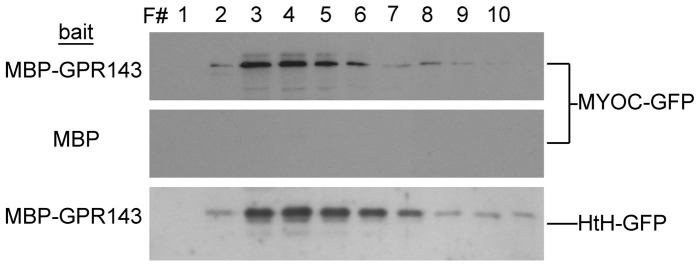
Interaction between myocilin and the cytoplasmic domain of GPR143.Recombinant GPR143-maltose binding protein (MBP) fusion protein or MBP alone were bound to immobilized amylose and lysates from COS cells expressing full-length myocilin tagged with GFP (MYOC-GFP) or the HTH domain (N-terminal 58 amino acids, HTH-GFP) of myocilin were passed over the columns. Columns were washed and bound proteins were eluted by competition with excess maltose. Shown are western blot analysis of elution fractions from columns containing immobilized GPR143:MBP or MBP. Results are representative of 3 experiments with each construct.